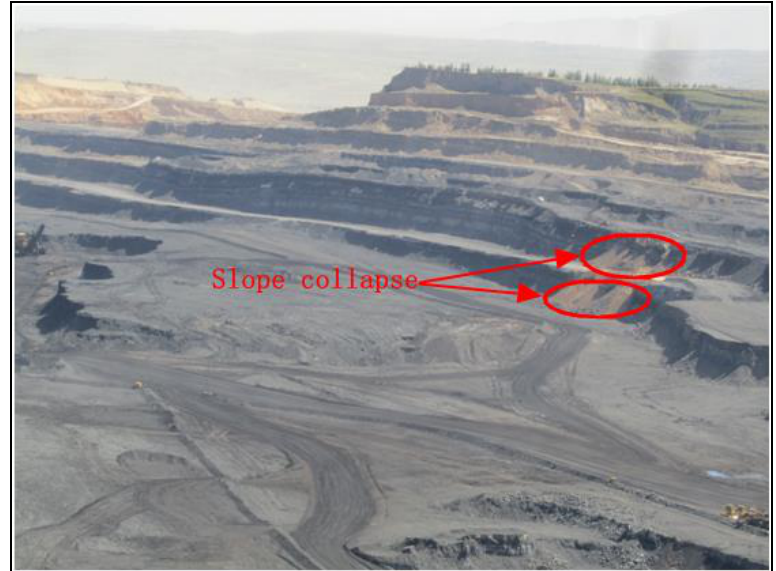
Figure 8. Two collapses occurred on the north slope in the Anjialing open-pit mine.